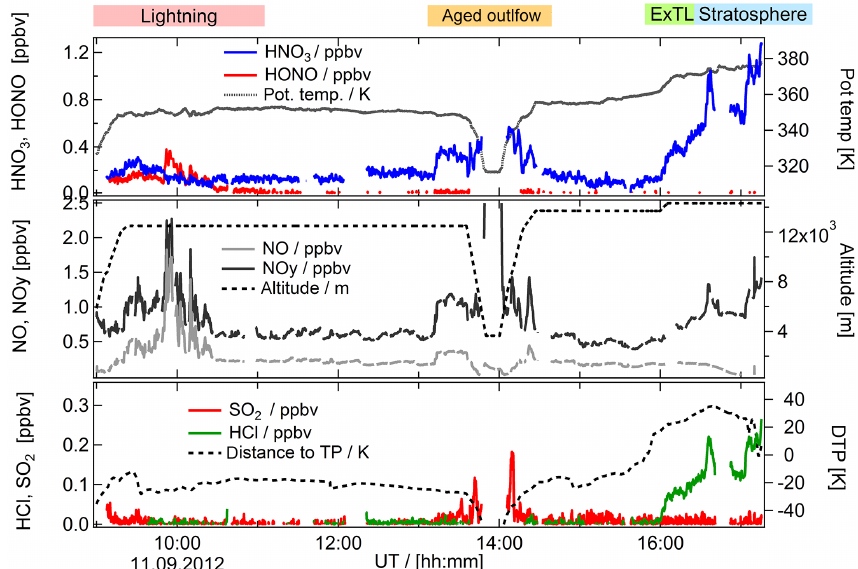
Figure 7. A time series of HNO 3 , HONO and temperature (upper panel), NO and NO y and altitude (middle panel) and SO 2 , HCl, distance to the tropopause (lower panel) from the flight on 11 September 2012 during the TACTS/ESMVal mission is shown. The aircraft started in Sal, Cape Verde, and landed in Cape Town, South Africa. Tropospheric tracers, with strong influences from lightning, were measured in the first part of the flight; HONO signatures are present in a thunderstorm west of Africa simultaneously with NO y , NO and HNO 3 . HONO mixing ratios of up to 0.38ppbv coincide with the NO enhancement, indicating a recent influence of lightning in decaying convective cells. In the second part of the flight, increases in SO 2 and HNO 3 were measured in aged outflow air at 9 and 11km, originating potentially from biomass burning in east Africa. The plume was encountered twice during descent and ascent of the profile. In the last part of the flight, HALO reached the stratosphere, indicated by simultaneous increase in HCl and HNO 3 and the distance to the